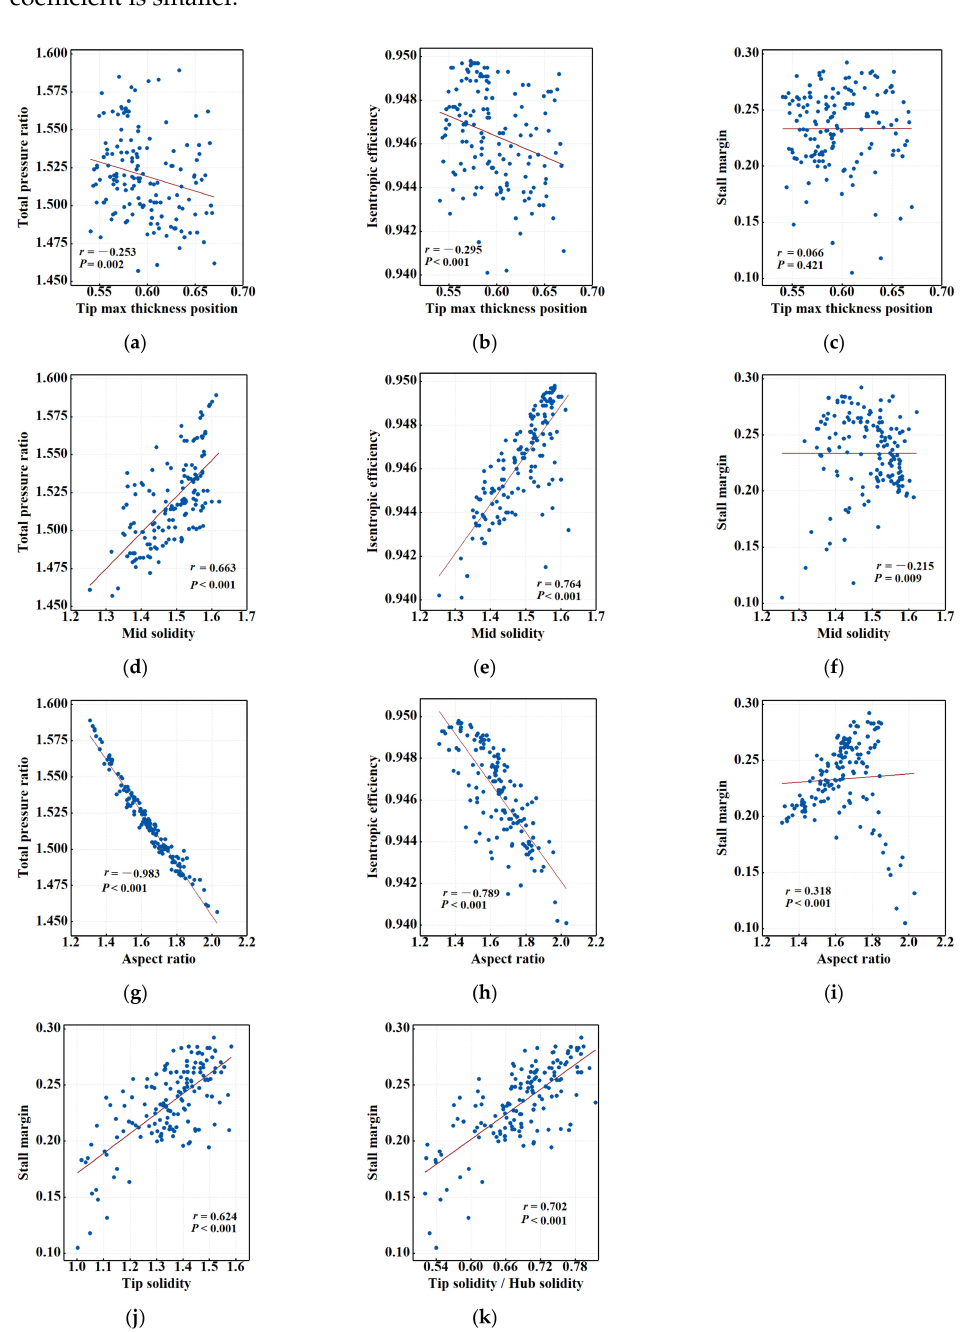
Figure 16. Results of parameter correlation analysis: ( a ) tip max thickness position and total pressure ratio; ( b ) tip max thickness position and isentropic efficiency; ( c ) tip max thickness position and stall margin; ( d ) mid solidity and total pressure ratio; ( e ) mid solidity and isentropic efficiency; ( f ) mid solidity and stall margin; ( g ) aspect ratio and total pressure ratio; ( h ) aspect ratio and isentropic efficiency; ( i ) aspect ratio and stall margin; ( j ) tip solidity and stall margin; ( k ) ratio of tip solidity to hub solidity and stall